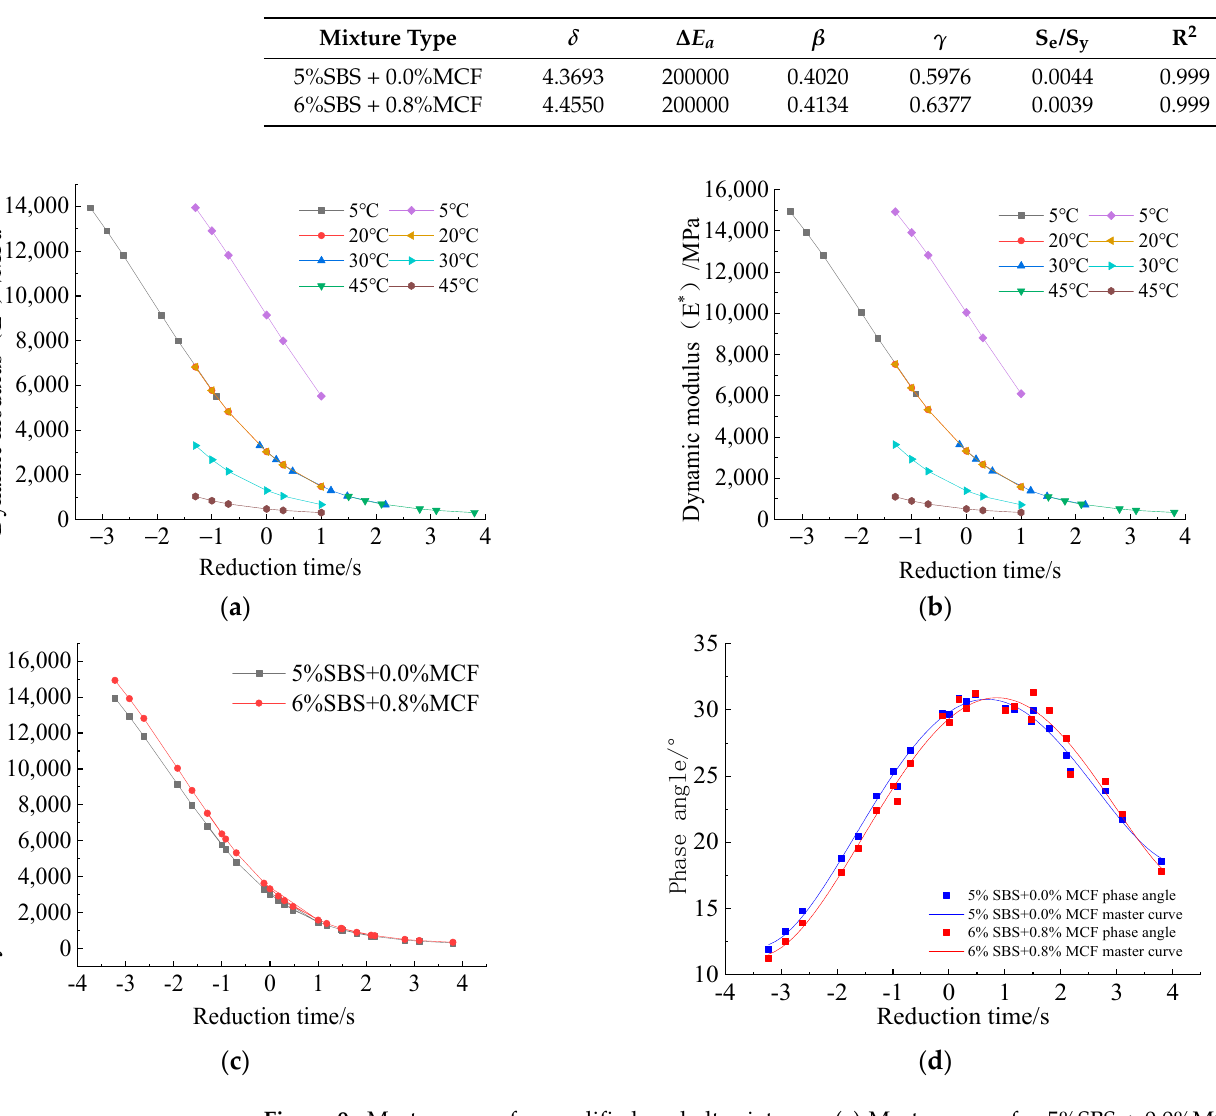
Table 12. Parameter values for master curve.